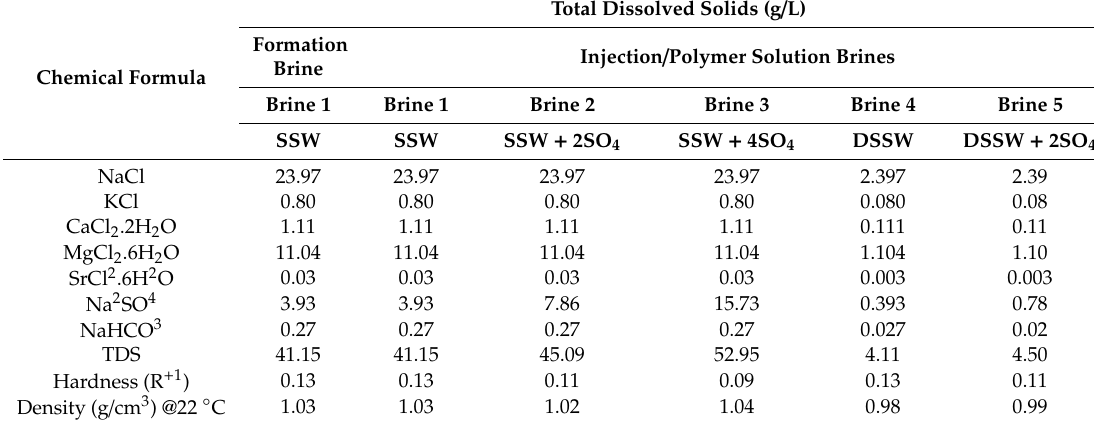
Table 1. Chemical composition of formation and injection